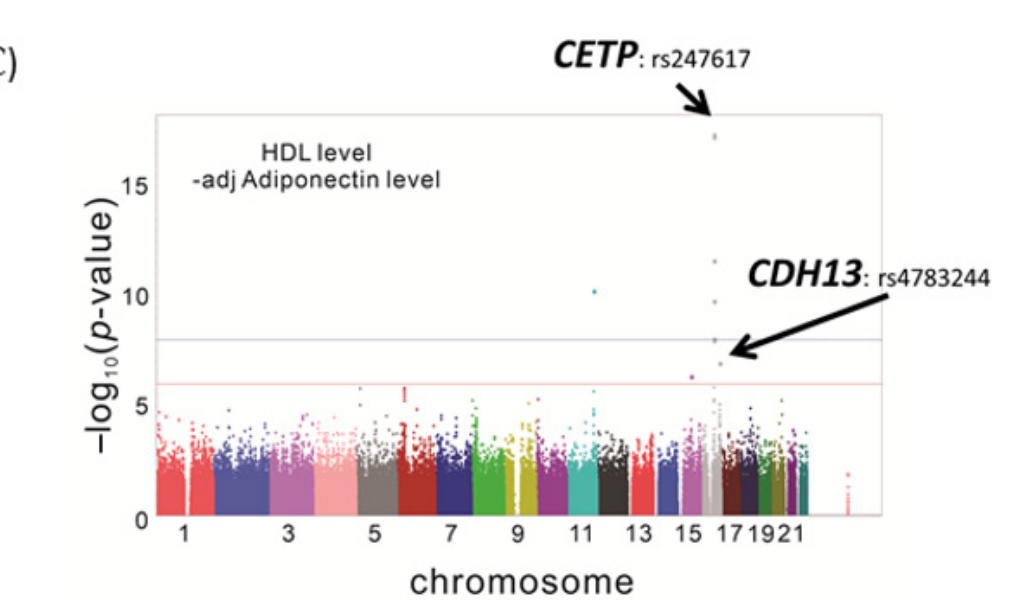
Figure 1. GWAS analysis of Adiponectin and HDL levels. Manhattan plots of genome-wide association study for Adiponectin and HDL levels. ( A ) The data revealed the genome-wide significant gene loci CDH13 in Taiwanese for Adiponectin levels. P value adjusted for age, sex, current smoking status and body mass index. ( B ) The data of the genome-wide significant gene loci CETP in Taiwanese for HDL levels. P value adjusted for age, sex, current smoking status and body mass index. ( C ) The data revealed the genome-wide gene loci CDH13 in Taiwanese for HDL levels became significantly after further adjusted for Adiponectin levels.